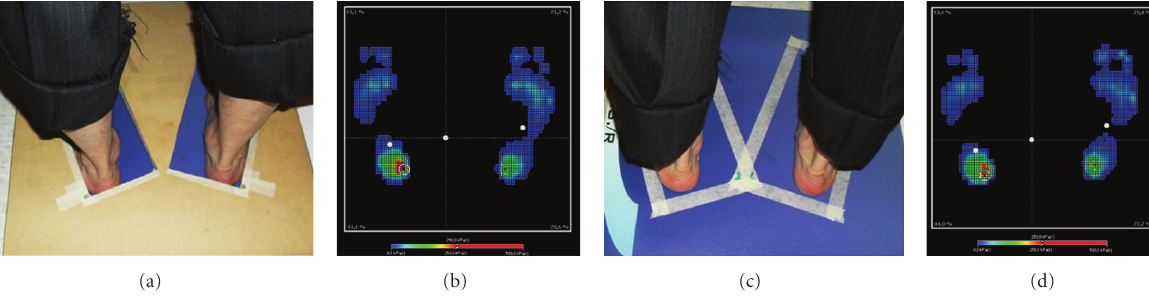
Figure 3: Two techniques following the anatomical position of the foot: (a) 3D wooden frame; (b) digital image of the pressure measurement with the 3D guide; (c) 2D frame; (d) digital image of the pressure measurement with the 2D